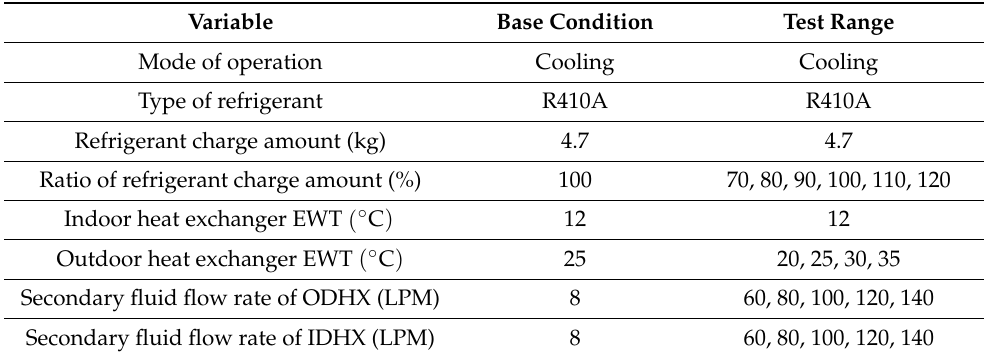
Table 1. Experimental conditions.